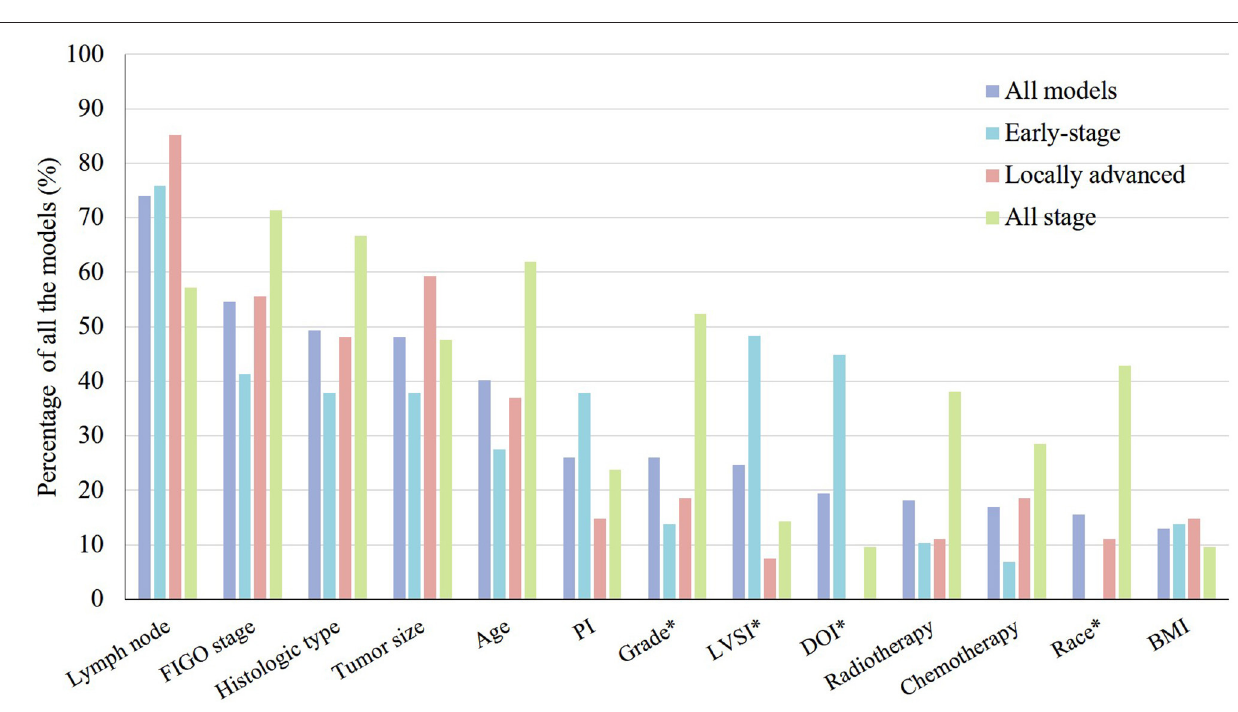
( n = 14; 48%), depth of stromal invasion (DOI) ( n = 13, 45%), FIGO stage ( n = 12; 41%), histological types ( n = 11; 38%), tumor size ( n = 11; 38%), and parametrium invasion ( n